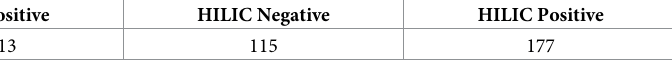
Table 1. Number of named metabolites collected under different modes.